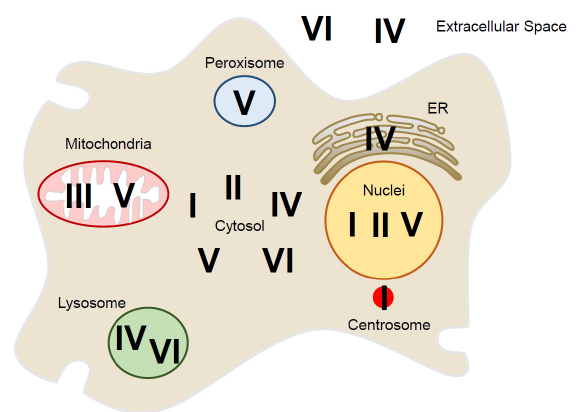
Figure 2. Localization of six peroxiredoxin isoforms (PrxI–PrxVI) inside and outside of the mammalian cell: In the cytosolic space, PrxI, II, IV, V, and VI are present. The nucleus has PrxI, PrxII, and PrxV, and mitochondria have PrxIII and PrxV. In the peroxisome, PrxV exists, and in the ER, PrxIV is present. The lysosome has PrxIV and PrxVI. PrxI is also associated with the centrosome. PrxIV and PrxVI are present outside of the cell.